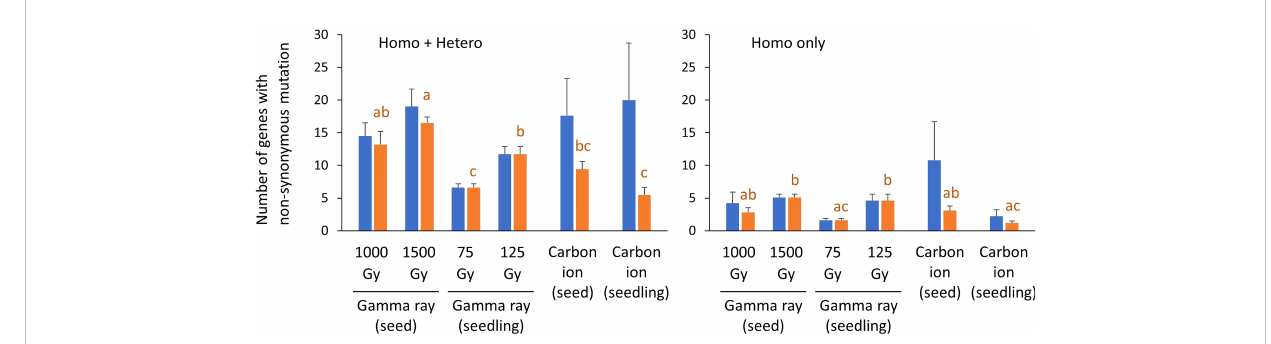
FIGURE 6 Number of protein-coding genes with non-synonymous mutations per sample. The blue bars indicate mean ± standard error in each irradiation condition. The orange bars indicate the same data but mutations that affect two more genes are excluded. The excluded deletions are listed in Supplementary Table 5. Transposable elements, pseudogenes, and non-coding RNA were not included. SVs with unknown overall structure were also not included. Data for dose 1 (~50% of D q ) and dose 2 (~75% of D q ) were merged for carbon ion irradiation. Different lowercase letters indicate a signi fi cant difference (one-way ANOVA with multiple comparison test, p<